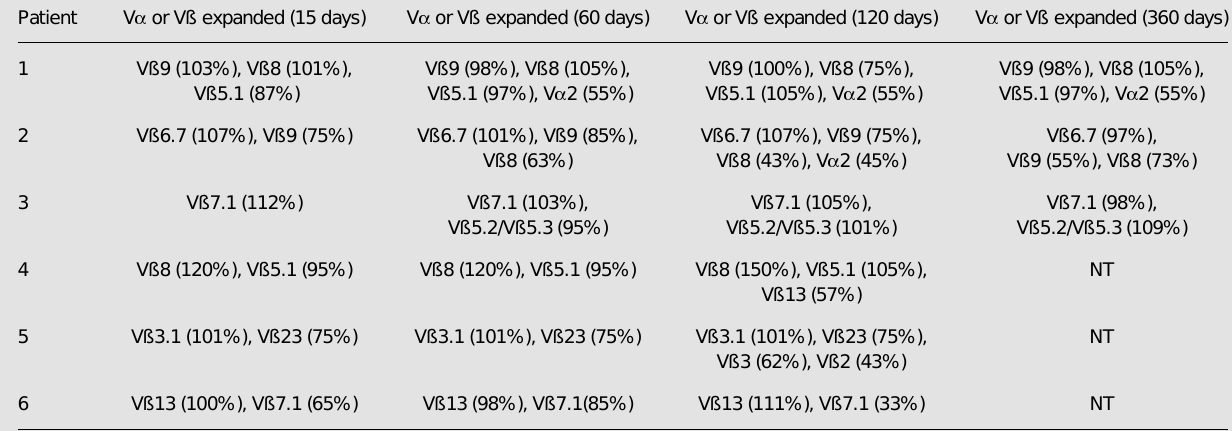
Table 2. Flow cytometry analysis of the V a and Vß expression by peripheral blood mononuclear cells from patients with acute toxoplasmosis after stimulation with soluble toxoplasma tachyzoite antigen